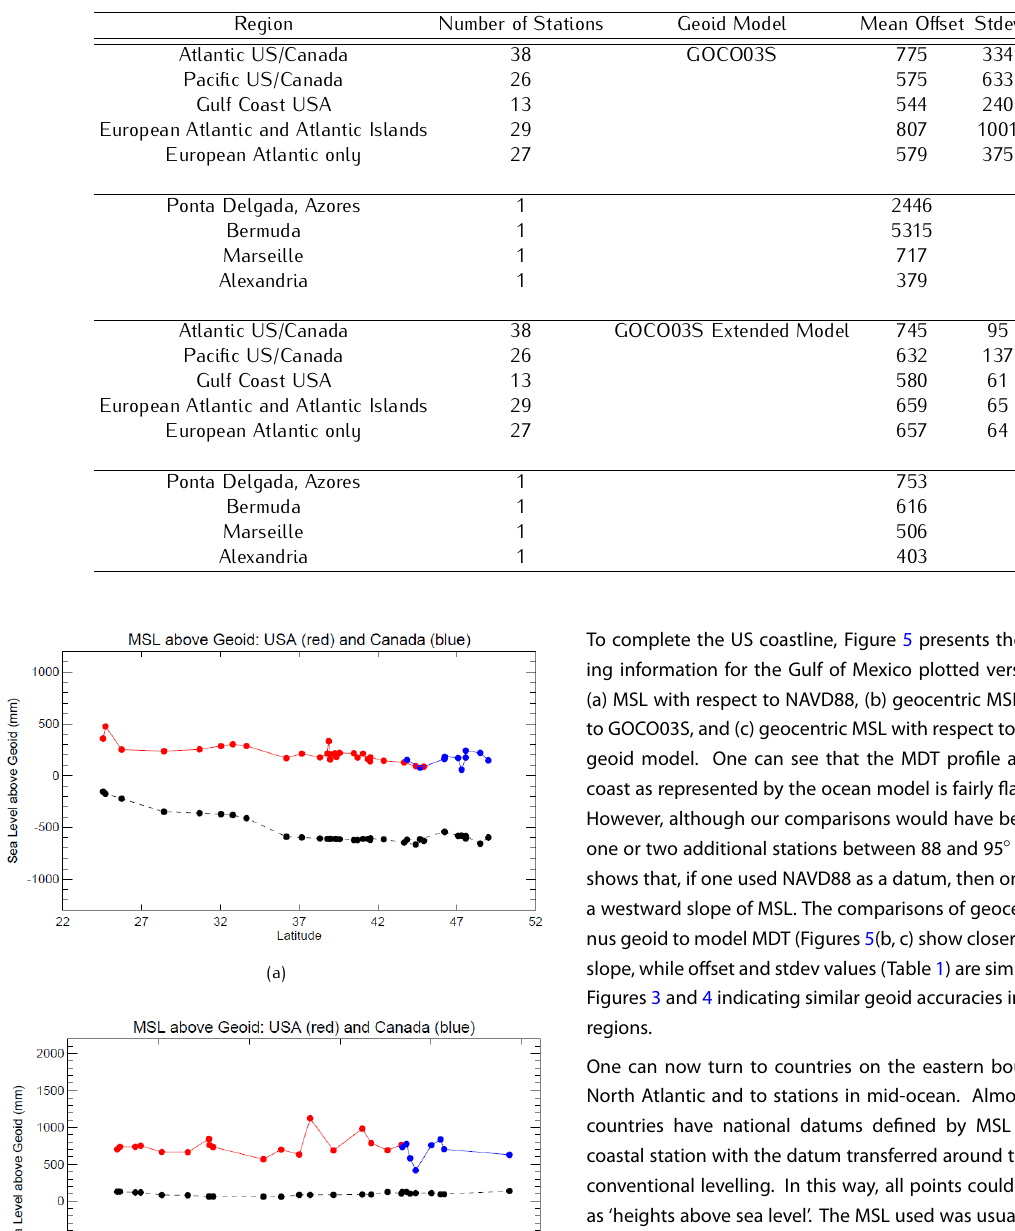
Table 1. Statistics of the differences between the MDT of the ‘geodetic approach’ using tide gauge data (ellipsoidal height of MSL minus geoid height) and the MDT of the ‘ocean approach’ at the same positions (using the Liverpool-MIT ocean model). Units are millimetres.